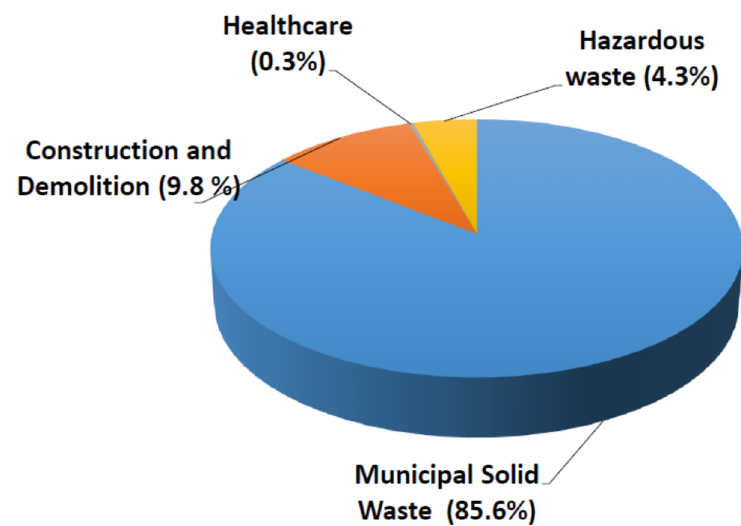
Figure 3. Composition of solid waste generated in Ho Chi Minh City [16].